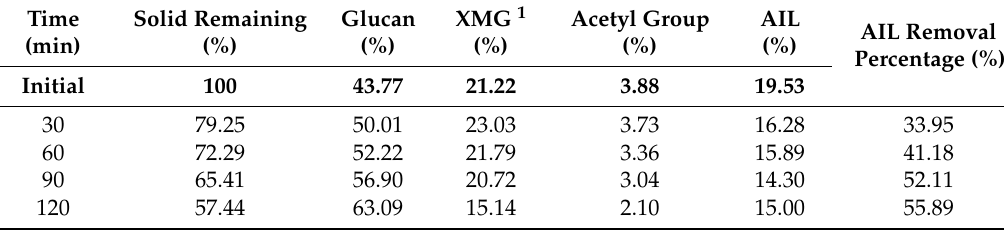
Table 2. Changes in composition of giant miscanthus after the combined ball mill and organosolv pretreatment performed at 170 ◦ C at 50 rpm rotation. XMG: xylan, mannan, and galactan; AIL: acid-insoluble